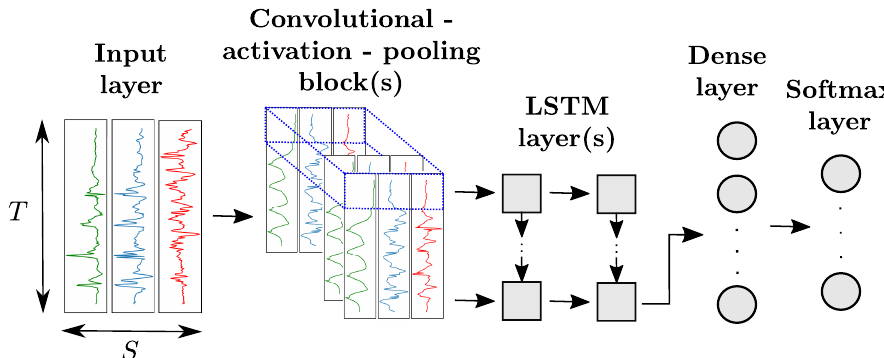
Figure 6. Architecture of a hybrid CNN+LSTM model for sensor-based HAR. Each slice along the time dimension of the output of the convolutional block(s) (in blue) is fed to one LSTM cell. All LSTM layers are organized in a many-to-many pattern, except the last which follows a many-to-one